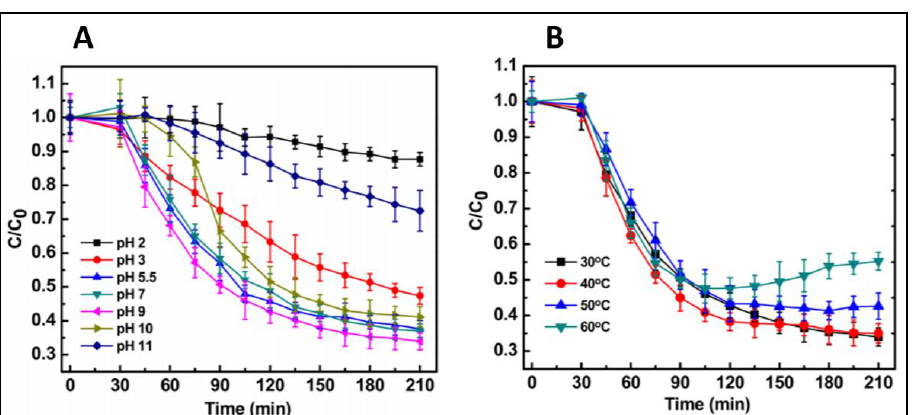
Figure 6. Degradation of CIP over time under different conditions. ( A ) the photocatalytic degradation of 10 mg/L CIP using 150 mg/L Fe-ZnO when irradiated with sunlight. The degradation was tested using different pH levels. The best photocatalytic efficiency is near a pH = 9. ( B ) represents the effect of temperature on CIP photocatalytic degradation at pH = 9. An unexpected trend was obtained as a decreasing in degradation efficiency when increasing the temperature up to 60 °C. C/C0 represents the relative change in CIP with respect to the initial concentration. Adapted from [91].